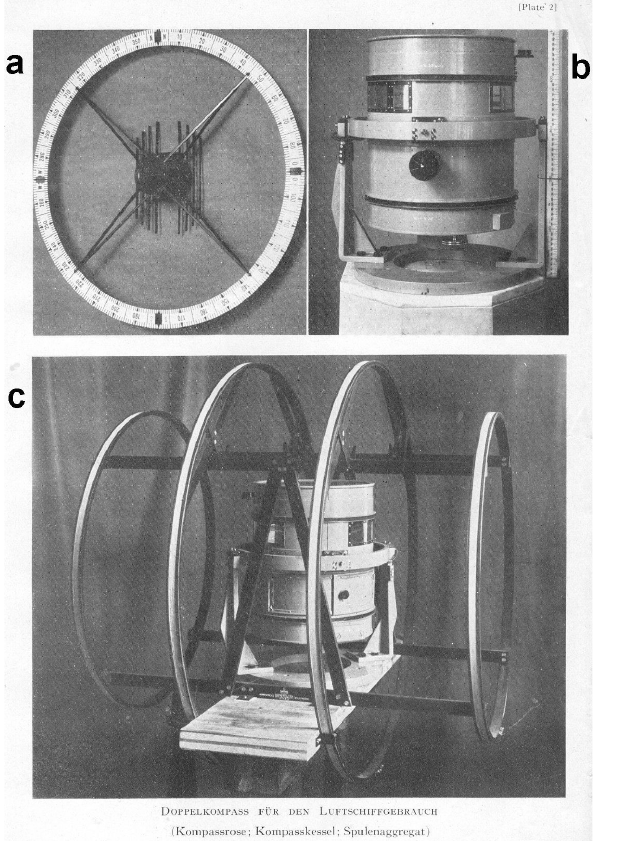
Figure 3. Double compass used to measure the geomagnetic field H component on board the Graf Zeppelin airship: (a) – card, (b) – the external view of the instrument, (c) – calibration rings (Grotewahl,